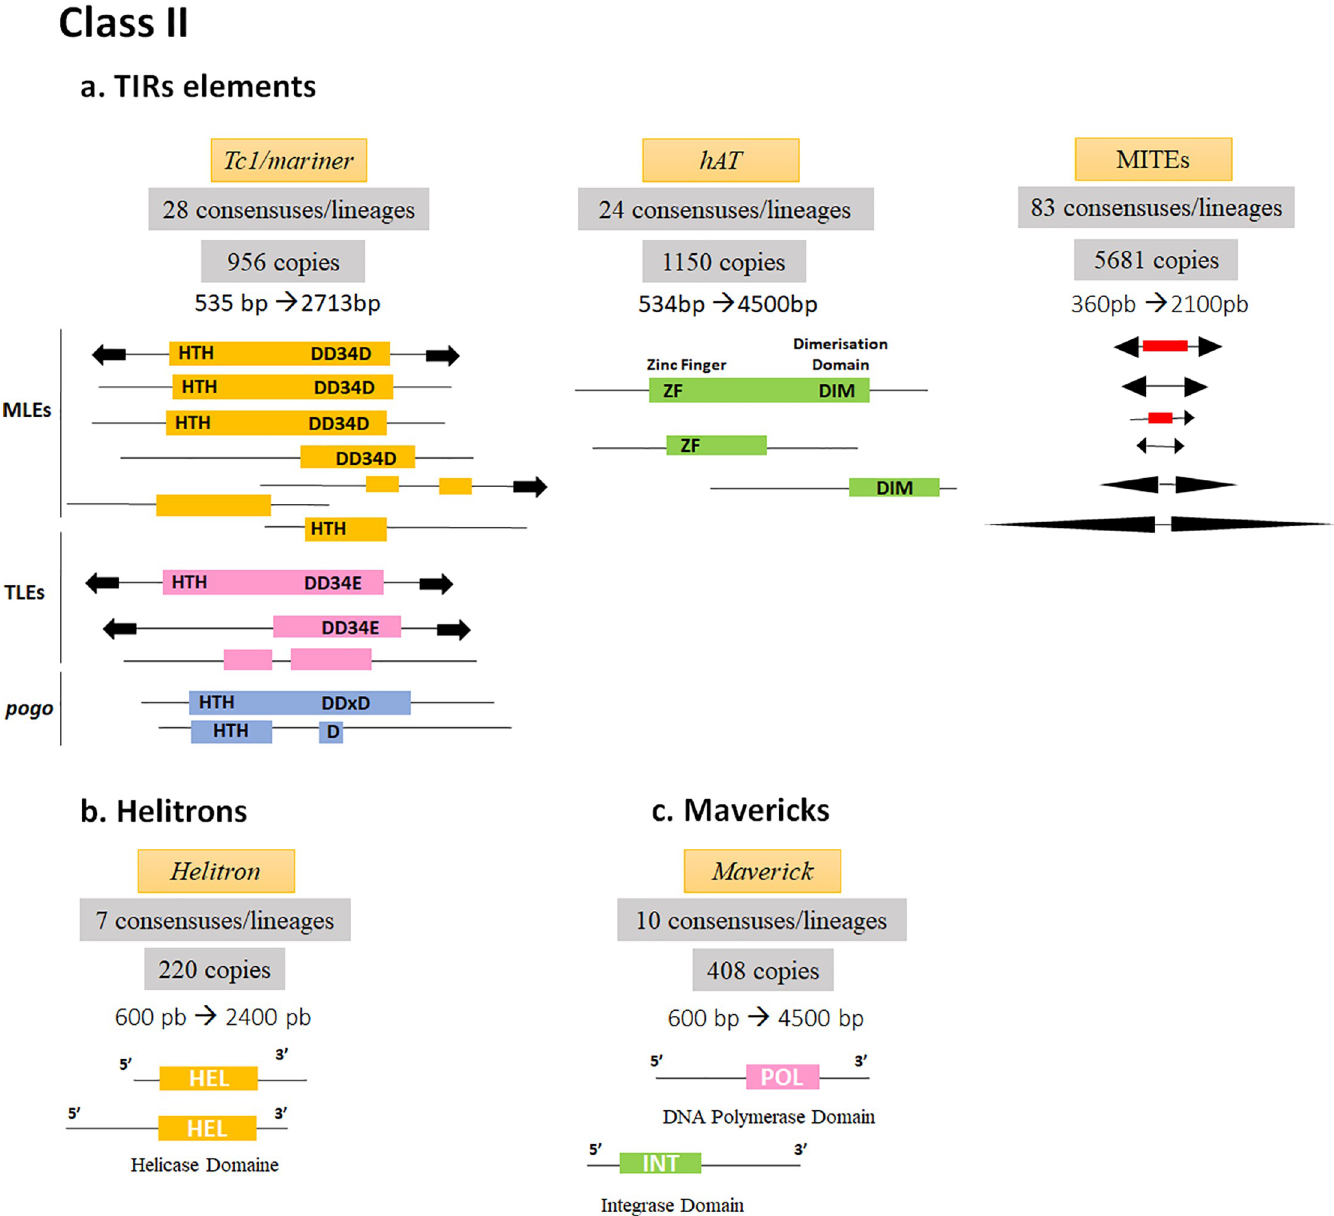
Fig 3. Schematic representation of class II TE structures in Mayetiola destructor genome. The numbers of copies and consensuses representing lineages of each Class II order are mentioned. Full-length copies and some inactive forms of DNA transposons are mentioned a. TIR elements. Only the most frequent superfamilies were represented, they correspond to the mariner -like elements (MLEs) and hAT as well as inactive TIR forms, the MITEs. TIR structures are represented by black bold arrows and ORFs are indicated by rectangles. Internal deletions are represented by thin black lines. In Tc1/mariner like elements, the Helix Turn Helix (HTH) region of the DNA binding domain is indicated as well as the three aspartic or glutamic amino acids (DDxD/E) characterizing the C-ter Tc1/mariner-like elements. In hAT transposons, the Zinc Finger and Dimerisation domains are shown in bold letters. b . and c. The inactive forms of helitrons and Mavericks are represented showing the 5’ or the 3’ regions with their appropriate